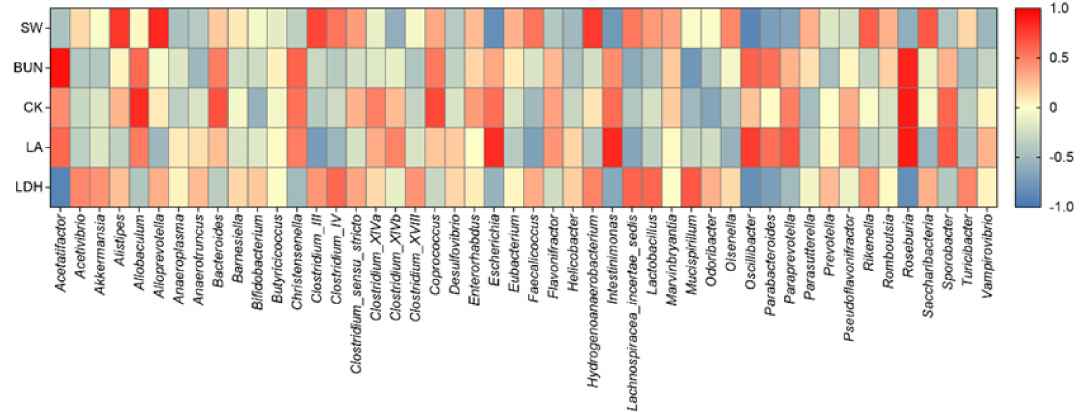
Figure 6. The correlation analysis between gut microbiota and anti-fatigue physiological characteris- tics. The correlation coefficient ranged from − 1.0 to 1.0. Red and blue indicate positive correlation and negative correlation, respectively. The SW indicated the exhaustive swimming time, LD represented lactic acid, BUN represented blood urea nitrogen, CK represented creative kinase, LDH represented lactate